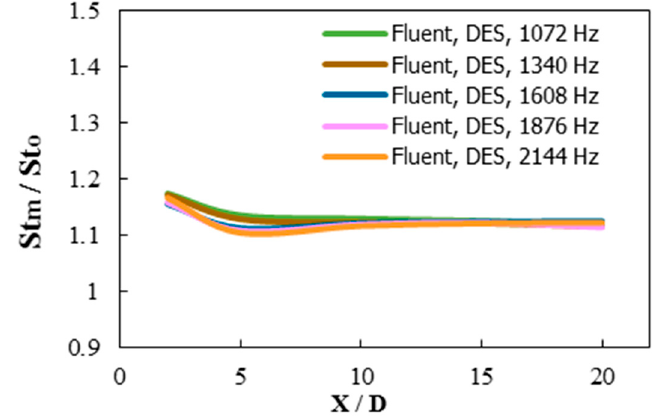
Figure 32. The spanwise-averaged Stanton number ratio obtained using the DES Realizable k - ε model for M = 0.5 for the 1072, 1340, 1608, 1876, and 2144 Hz oscillations.